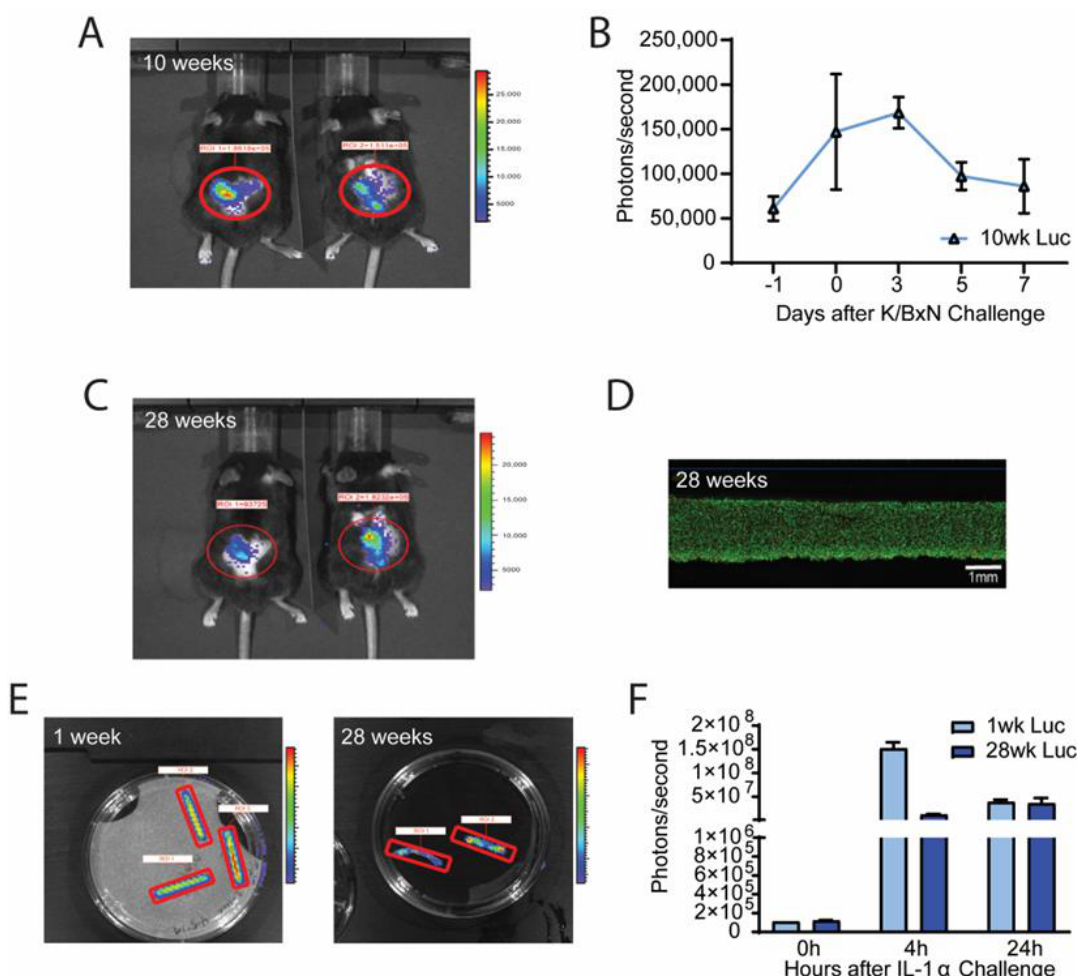
Figure 3. ( A ) Luminescence activity by IVIS 10 weeks after Ccl2-Luc agarose construct implantation indicates that cell activation peaked over the first 3 days after K/BxN serum challenge ( B ). ( C ) Luminescence activity by IVIS from Ccl2-Luc agarose constructs 28 weeks after implantation indicates cell activation after repeated K/BxN challenge. ( D ) Ccl2-Luc constructs demonstrated predominantly live cells upon explantation at 28 weeks, scale = 1 mm. ( E , F ) Ccl2-Luc constructs explanted after 1 and 28 weeks of implantation and challenged with 1 ng/mL IL- 1α exhibited robust luminescence intensities ex vivo. n = 5 – 10 animals/group compared by 2-way repeated measures ANOVA and Dunnet’s or Tukey’s post -hoc test, n = 2 – 8/group/timepoint.